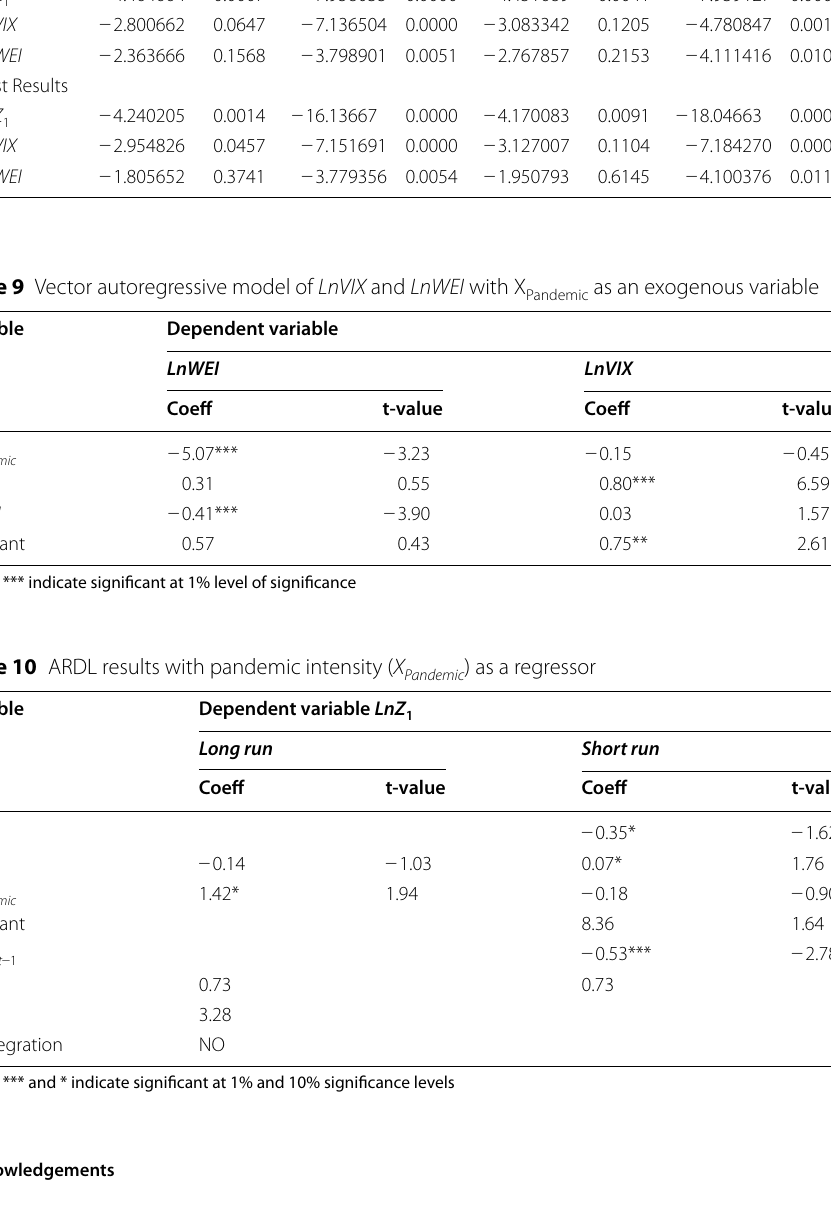
Table 8 Unit root tests